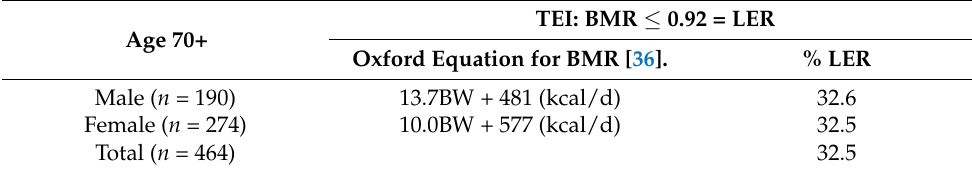
Table 1. Equations to determine proportion of low energy reporters